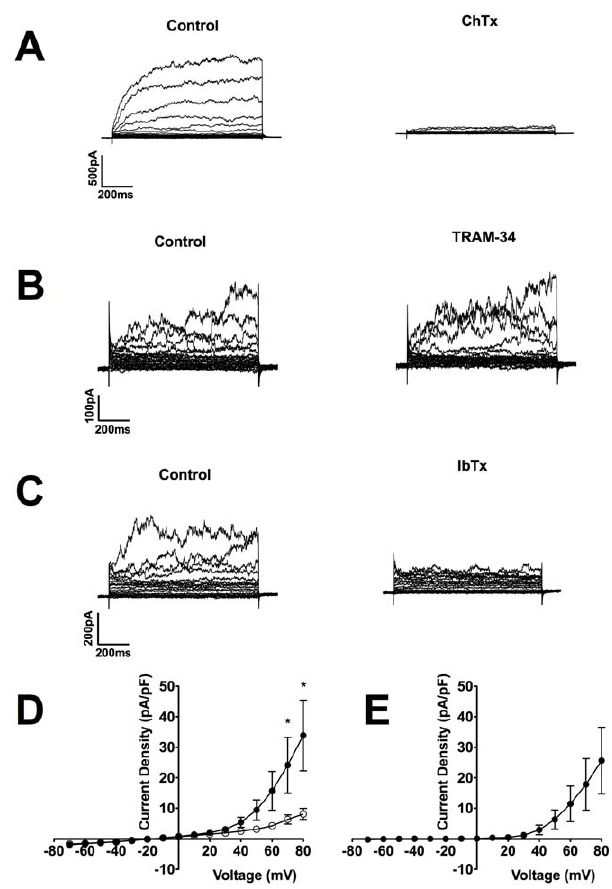
Figure 4. Characterisation of Ca 2 + -activated K + channel iso- forms in CPASMCs. Representative example of the inhibition of outward currents by the BK Ca and IK Ca blocker charybdotoxin (ChTx; n=4; N=2; 100 nM; A ), but not the specific IK Ca inhibitor TRAM-34 (n=3, N=2; 10 m M; B ). The specific BK Ca blocker iberiotoxin (IbTx; 100 nM; C ) inhibited outward currents at depolarised potentials. Mean current-voltage relationships measured at the end of the 500 ms N voltage step ranging from -70 mV to + 80 mV were obtained in the ) and presence ( # ) of IbTx ( D ; *P , 0.05; Two-way ANOVA absence ( followed by Bonferroni Post Hoc Test; mean 6 SEM; n=8, N=4). IbTx- sensitive currents ( E ) were outwardly rectifying. (N = 4; Figure 2D) and synthetic NMMHC-B (N= 4; Figure 2E) SMCs. The endothelium was clearly visible with CD31 staining (N-4; Figure 2B). No staining was evident in either CPASMCs (N = 4; Figure 1F) or CPA sections (N= 4; Figure 2F) following substitution of primary antibody with non-immune IgG at an equivalent concentration.